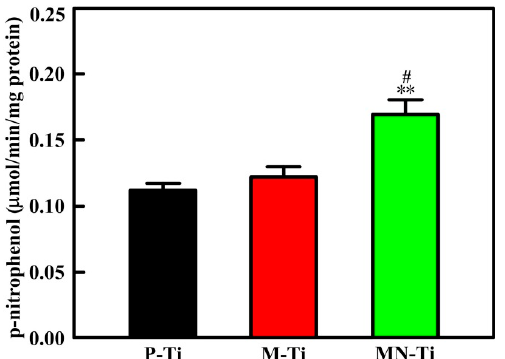
Figure 11. ALP activity of MC3T3 cells adhered to different Ti samples after culture for 7 days. # p < 0.05 compared with the M-Ti sample. * p <0.05 compared with the P-Ti sample. ** p < 0.01 compared with the P-Ti